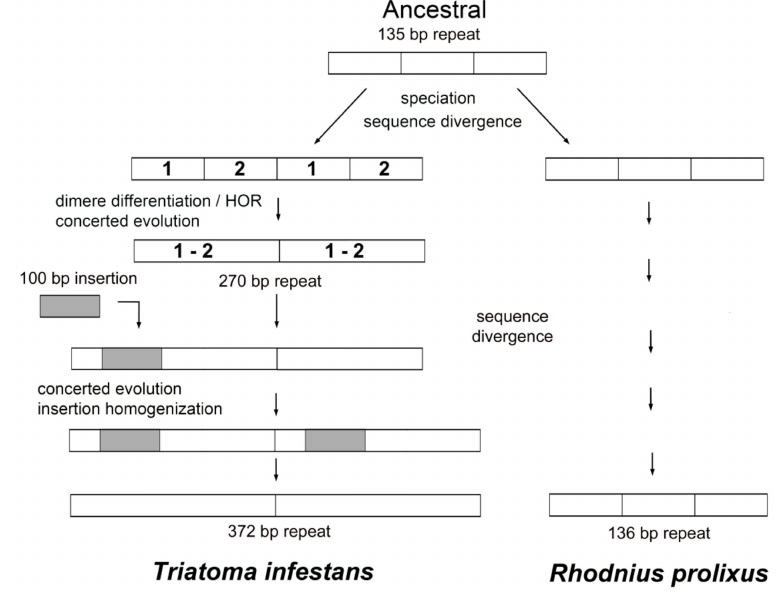
Figure 5. Hypothetical pathway of the TinfSat33-372 satellite DNA in T. infestans and R. prolixus . The ancestral situation would be the existence of a satDNA family with a repeat unit of 135 bp. This organization is conserved in the R. prolixus genome with a repeat unit of 136 bp. The repeat unit of 372 bp of T. infestans would has been generated from the ancestral satDNA by HOR formation and an insertion of a sequence of about 100